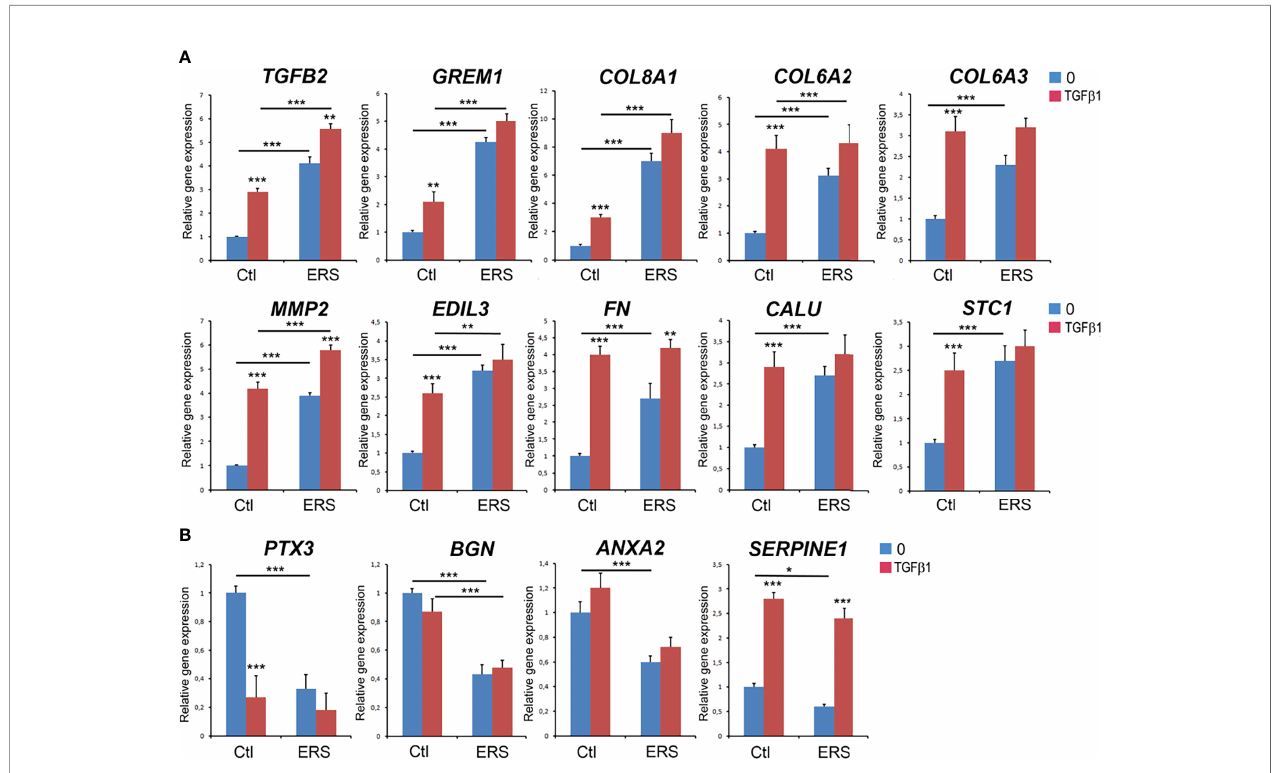
FIGURE 3 | Real Time RT-PCR analysis of candidate genes corresponding to secreted proteins with differential abundance characterized in proteomic analysis. GFs from control and ERS cultured without TGF b 1 (blue columns) or with TGF b 1 (5 ng/ml; red columns) for 6 hours. (A) Selected secreted candidates with increased abundance: TGF b 2 , Gremlin 1 ( GREM1 ), Collagen alpha (1) type VIII ( COL8A1 ), Collagen alpha (2) type VI ( COL6A2 ), Collagen alpha (3) type VI ( COL6A3 ), Matrix Metallopeptidase 2 ( MMP2 ), EGF Like Repeats and Discoidin Domains 3 ( EDIL3 ), Fibronectin ( FN ), Calumenin ( CALU ) and Stanniocalcin 1 (STC1). (B) Selected secreted candidates with decreased abundance: Pentraxin 3 ( PTX3 ), Biglycan ( BGN ), Annexin A2 ( ANXA2 ), and Plasminogen Activator Inhibitor-1 ( Serpine1 ). Control values correspond to the mean of 3 independent experiments in triplicates of three control cultures. ERS values correspond to the mean of 3 independent experiments in triplicates of the four ERS patient cultures. Datas represent mean fold gene expressions ± s.d. relative to control (without TGF b 1). Data was analyzed via two-way ANOVA with Bonferroni multiple comparisons test (*p < 0.05, **p < 0.01, ***p <